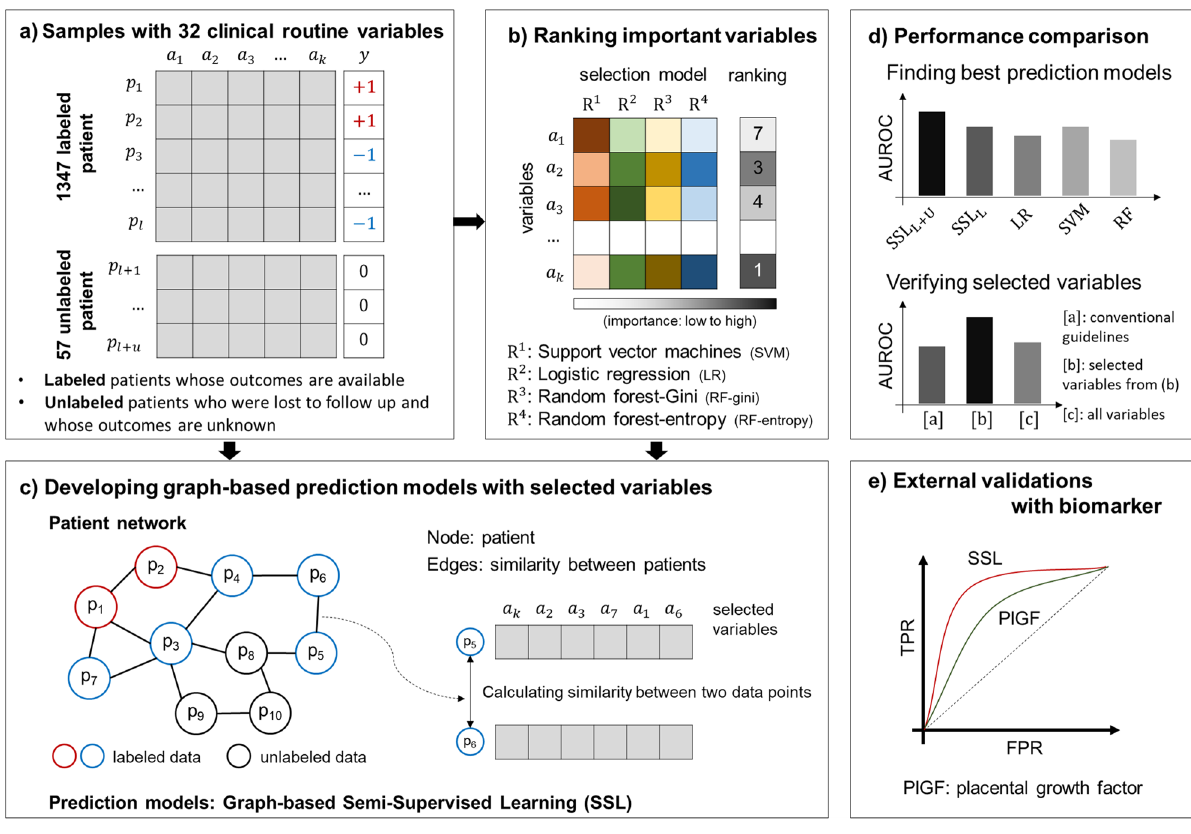
Figure 4. Overall